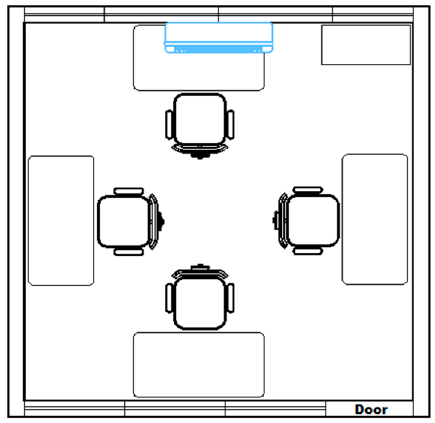
Figure 1. Experimental scenario layout.